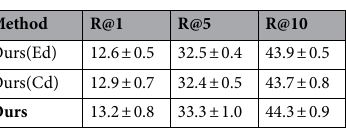
Table 8. Ablation studies of loss function on MIT-States